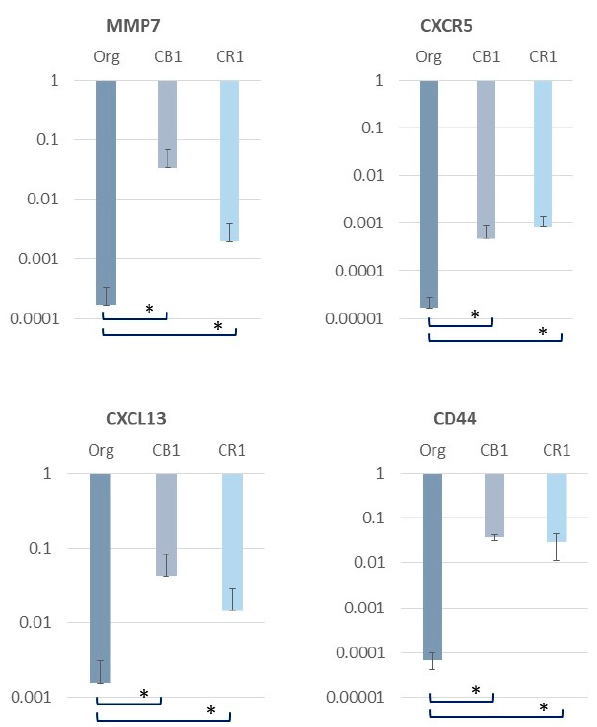
Figure 2. Real-time RT-PCR revealed significantly higher expression levels of MMP7, CXCR5, CXCL13 and CD44 in a subline of MT-2 continuously exposed to asbestos, CB1 exposed to chrysotile B and CR1 exposed to crocidolite, compared with the expression in original MT-2 cells untreated with asbestos fibers. Statistical significance was analyzed using Log 10 values, student t test, * p <